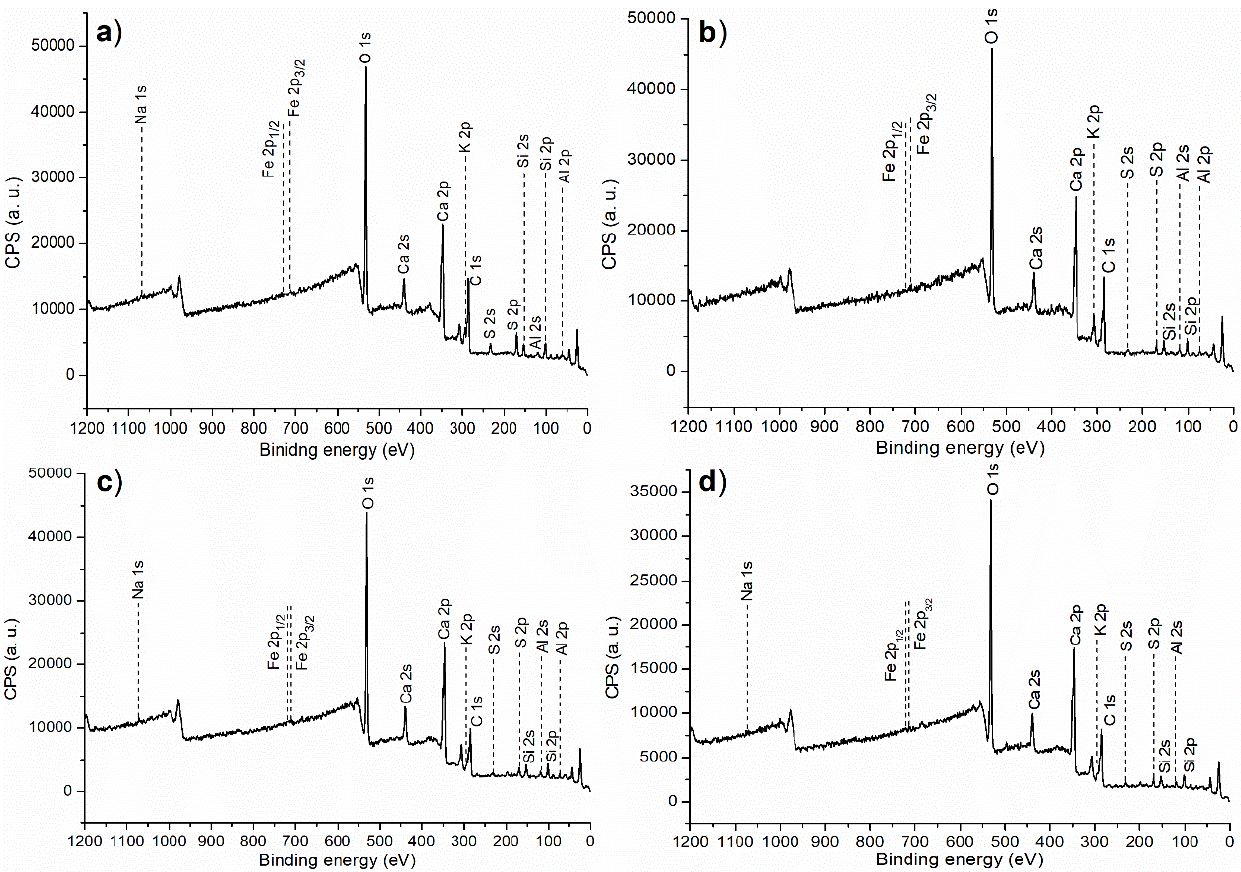
Figure 2. XPS survey scan: ( a ) Cement, ( b ) sample 2, ( c ) sample 7, and ( d ) sample 10.